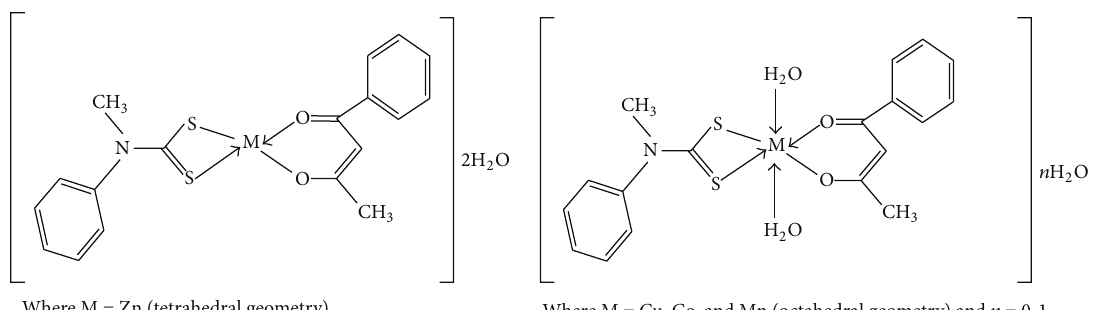
Figure 2: Proposed geometry of the mixed ligand complexes.